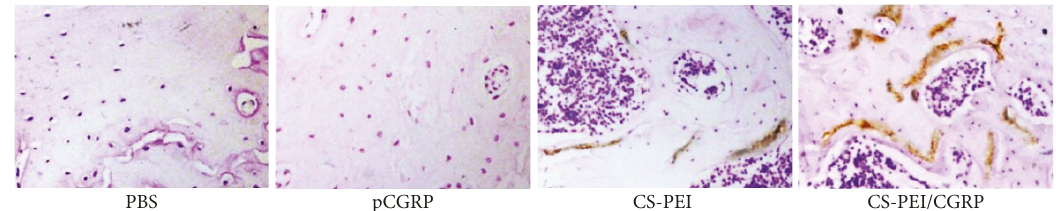
Figure 7: CGRP immunohistochemical result in callus of rat femoral fracture model after a 3-week treatment with